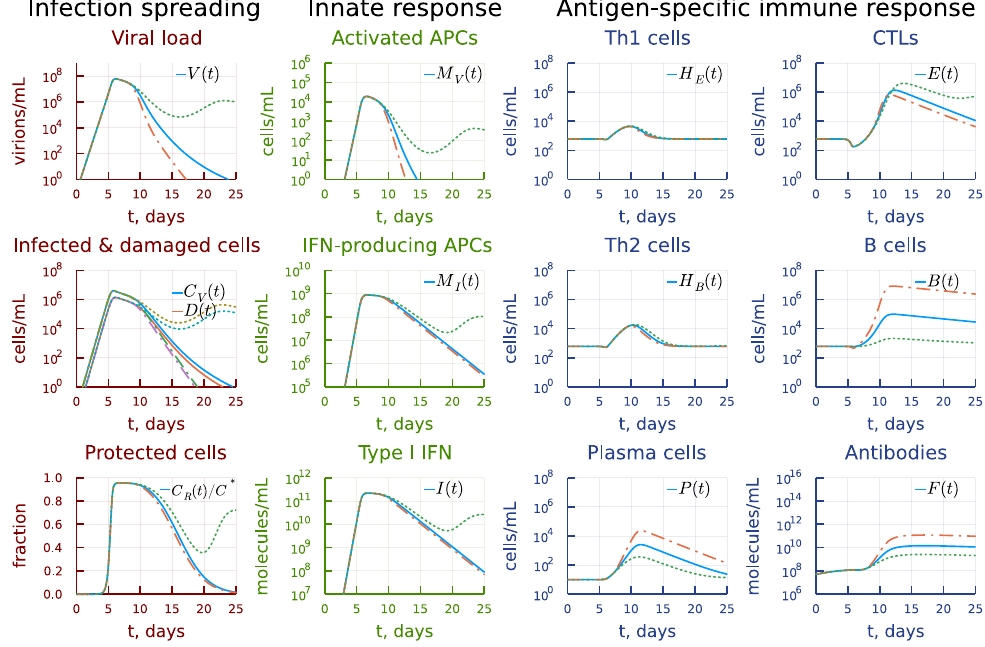
Figure 11. Effect of the rate constant of the B cell clonal activation. Dashdot: 10-fold increase of b B p , dot: 10-fold decrease of b B p relative to baseline